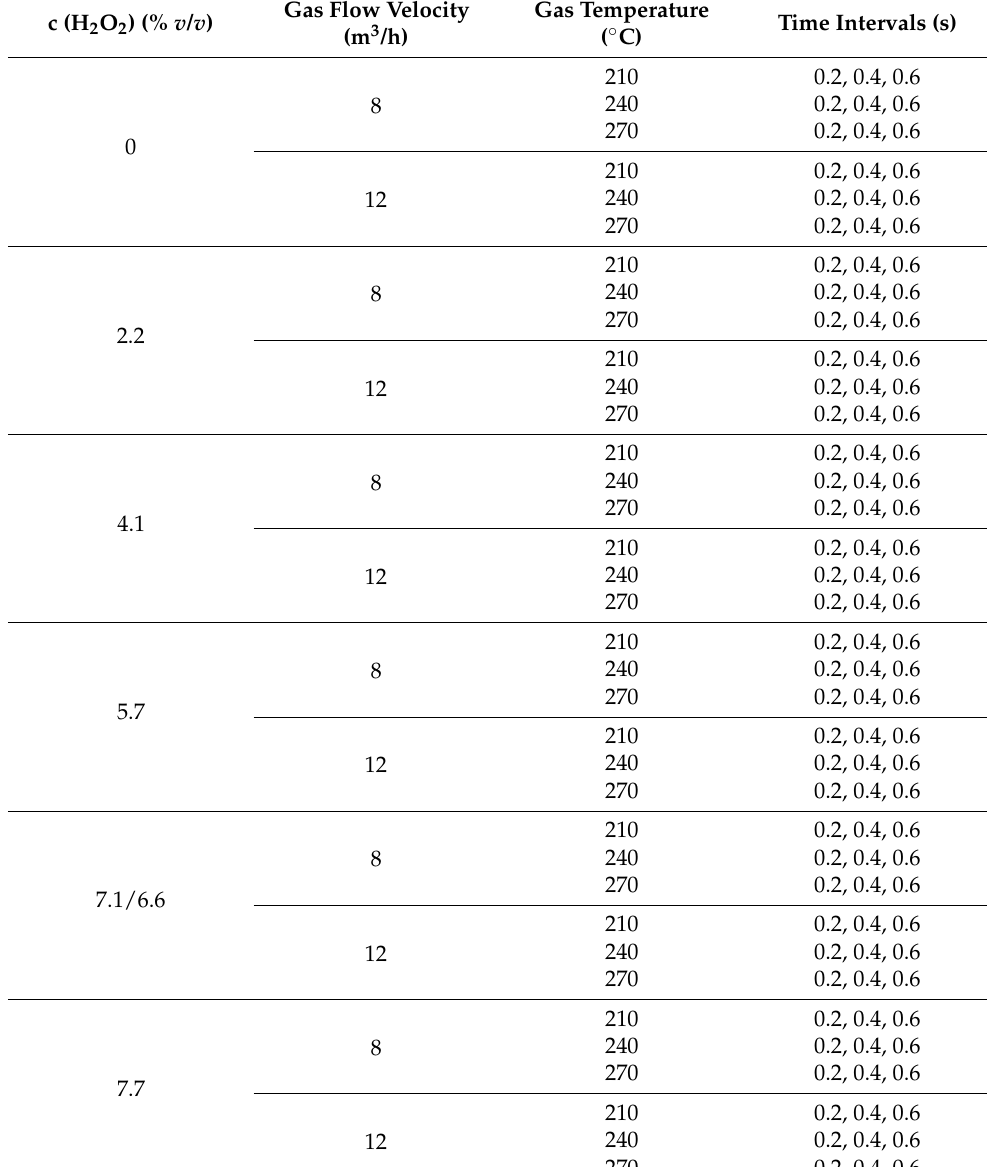
Table 1. A table of the varying conditions applied to the spore sterilization